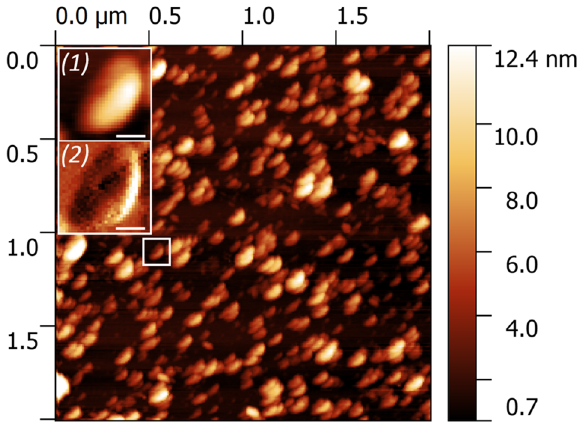
Figure 2. Large-scale atomic force microscopy (AFM) image of EV derived from CCM of glioma cells. The insertions demonstrate the height ( 1 ) and phase shift ( 2 ), revealing a cup-shape effect. The scale bar is 40 nm.